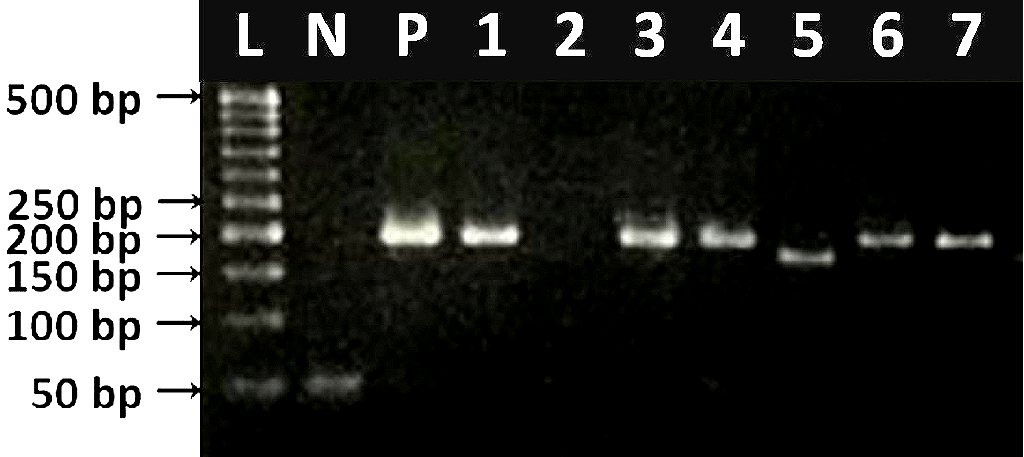
Figure 2. Agarose gel electrophoresis (2% agarose), showing amplified DNA (F2R2 primers, 175–200 bp) for 16S rRNA gene of hemoplasmas. L = 50 bp DNA ladder; N = negative control; P = positive control ( Mycoplasma ovis ); 2 = negative sample of uninfected animal; 1, 3–7 = genomic amplicons of infected animals.